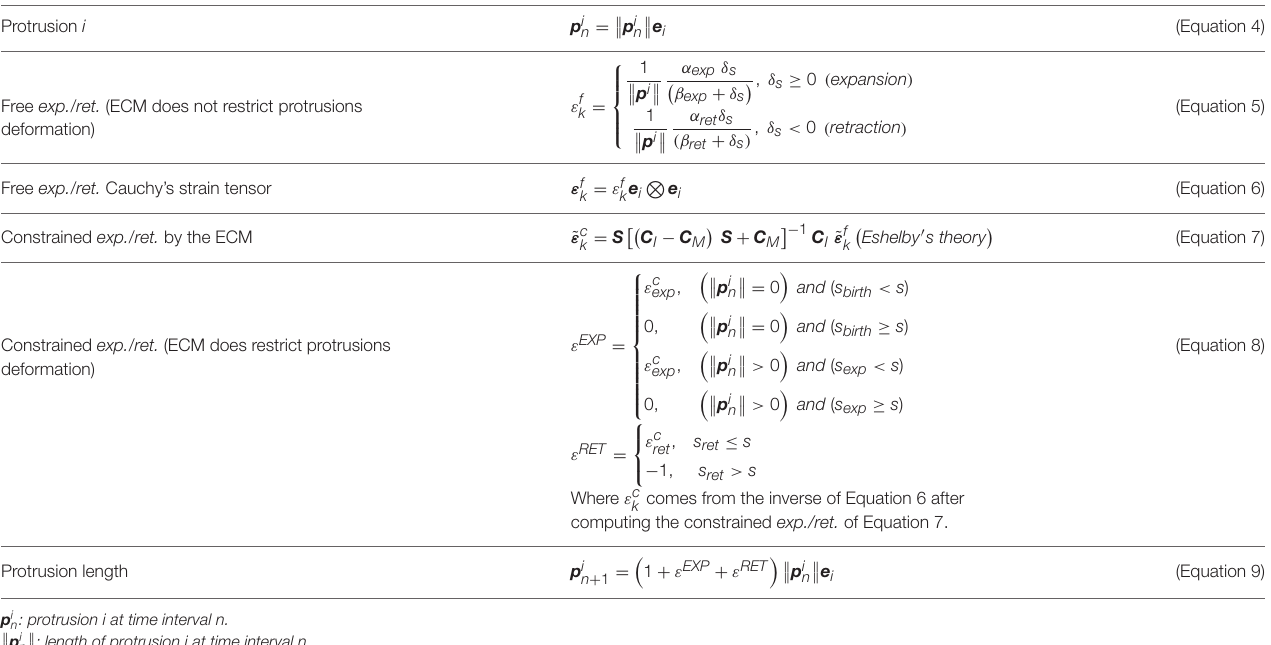
TABLE 2 | Equations associated with the protrusions dynamics. Protrusion